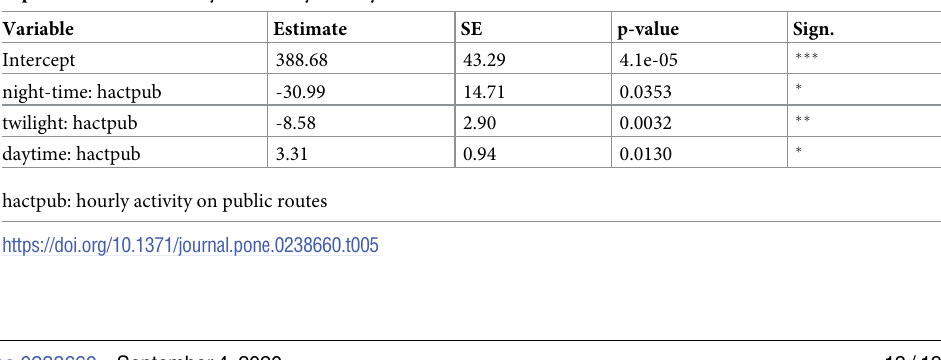
Table 5. Linear mixed-effects model explaining distance of black grouse GPS locations towards public routes in dependence of time of day and hourly activity. Variable Estimate